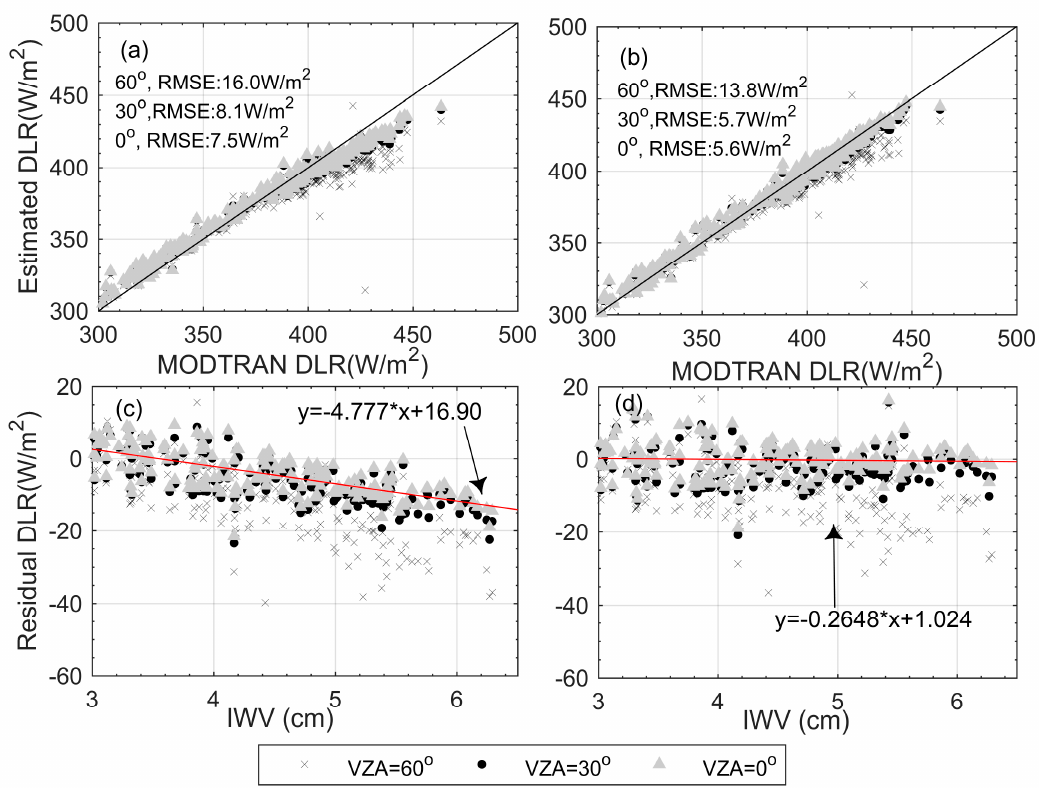
Table 2. For small VZA (< 60°), more than 99% of the DLRs had accuracy within 20 W/m 2 , an improvement of 0.5% compared with Yu2013 algorithm. At large VZA (= 60°), the accuracy increased by 16.9%.